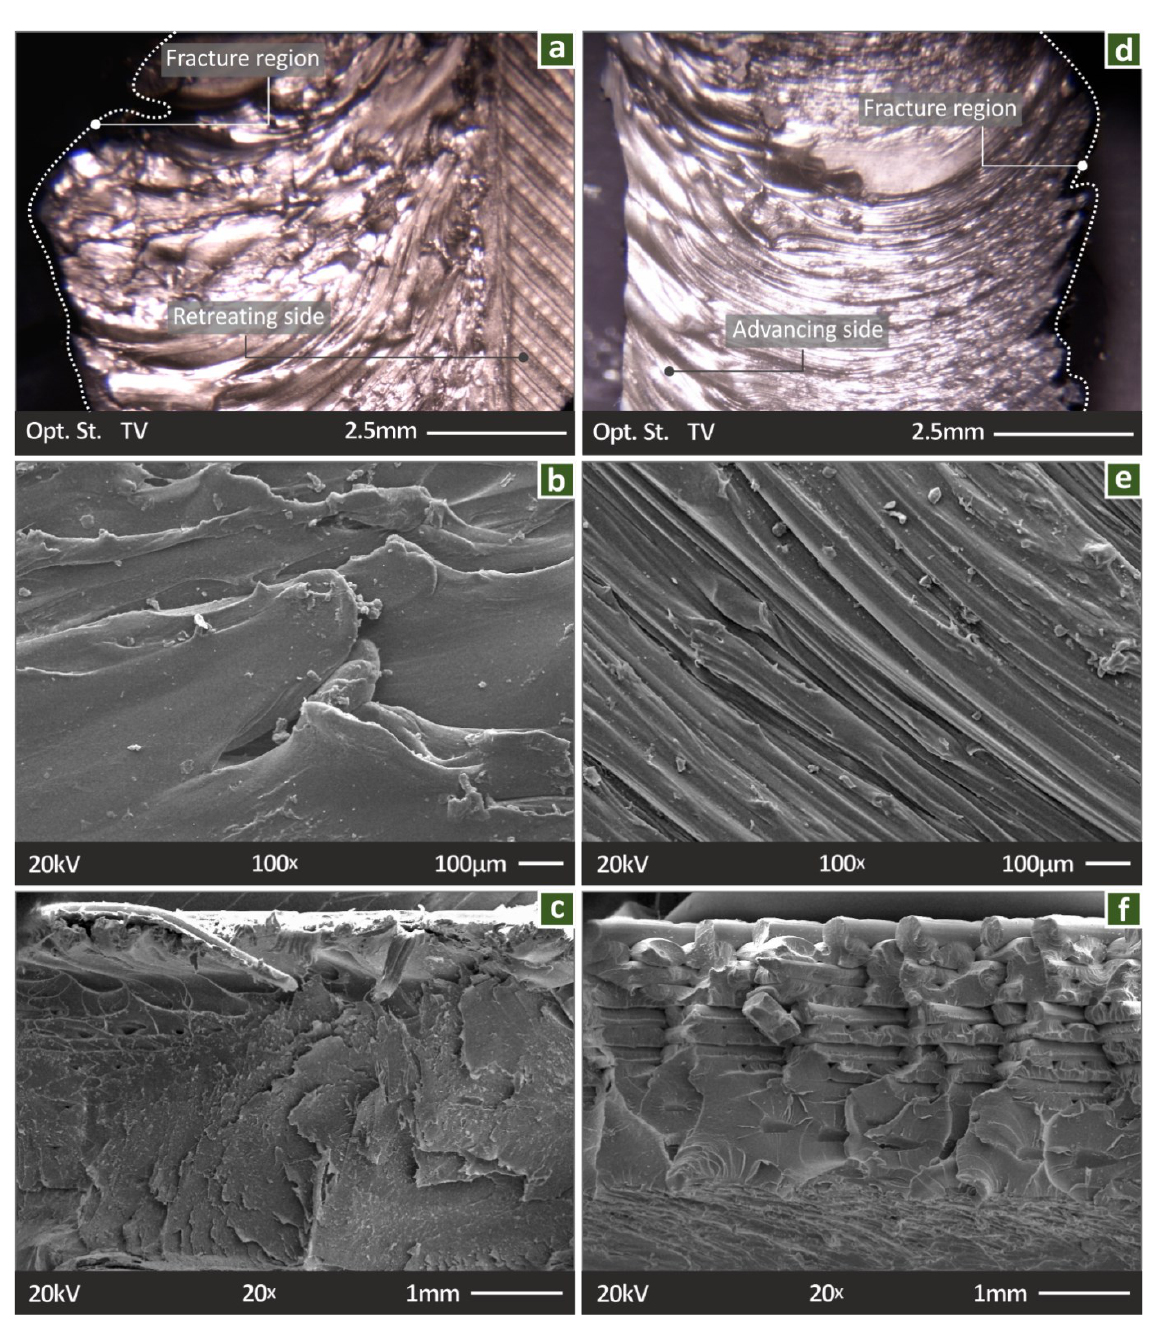
Figure 8. PPA tool: ( a ) top view of the seam, ( b ) SEM top view at the center of the joint, ( c ) SEM image of the fractured cross-section of the joint; PPB tool: ( d ) top view of seam, ( e ) SEM top view at the center of the joint, and ( f ) SEM image of the fractured cross-section of the joint.